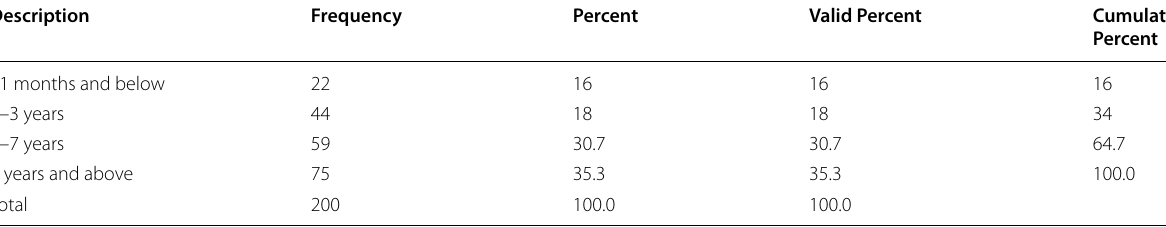
Table 7 How long the respondents have been in Hunan Province